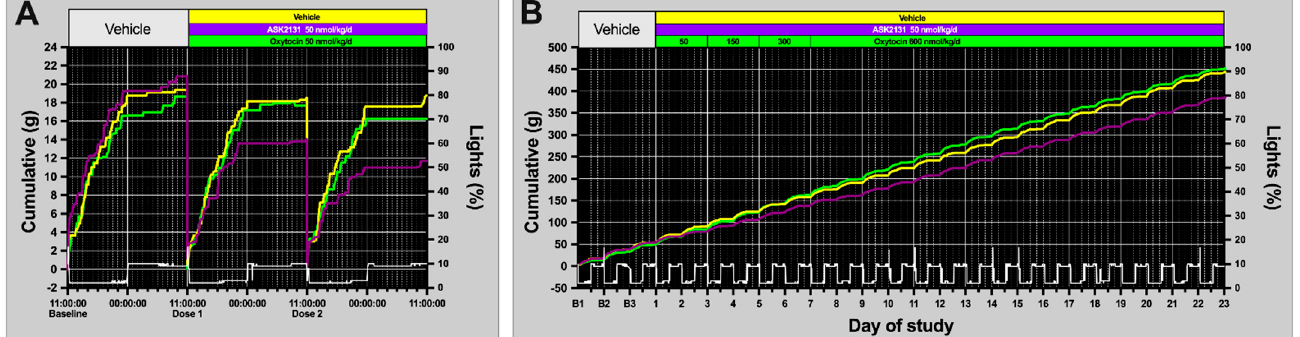
Figure 3. Analysis of food intake pattern of continuously automatically recorded food intake of singly housed rats in BioDAQ cages. Strong reductions of food intake were noted already at days 1 and 2 during treatment with ASK2131, but not to OXT compared to baseline, both drugs at 50 nmol/kg ( A ). Cumulative food intake throughout the whole experiment was more reduced in response to ASK2131 than to oxytocin, even when doses were increased for oxytocin every 2 days up to 600 nmol/kg while the dose for ASK2131 was kept at 50 nmol/kg/d ( B ). Green—Vehicle; yellow—Oxytocin; purple—ASK2131; White - ambient light data recorded by BioDAQ system.